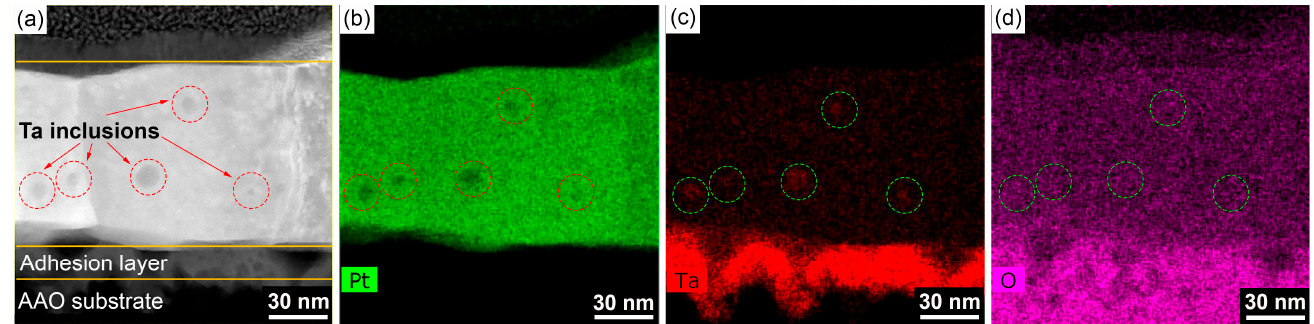
Figure 3. High-angle annular dark-field scanning transmission electron microscopy of the cross-section of Ta/Pt film annealed at 730 °C for 12 h ( a ). Energy-dispersive X-ray spectroscopy maps of the elements Pt ( b ), Ta ( c ), and O ( d ).